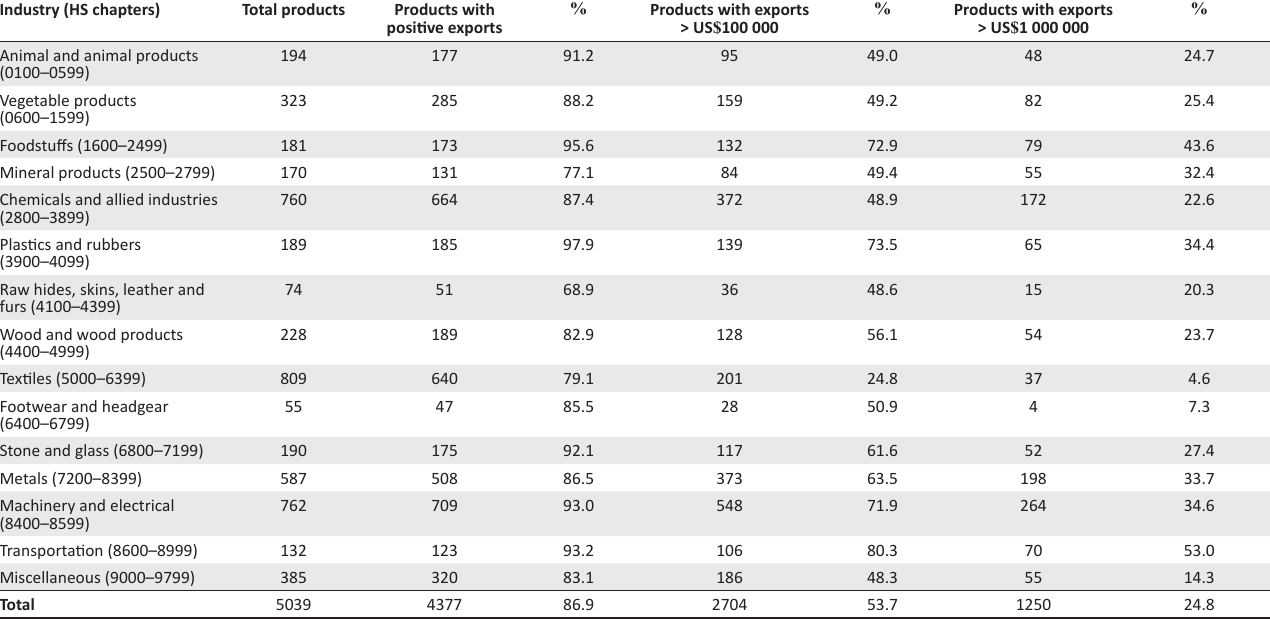
TABLE 1: Varieties of products exported by industry (2012). Industry (HS